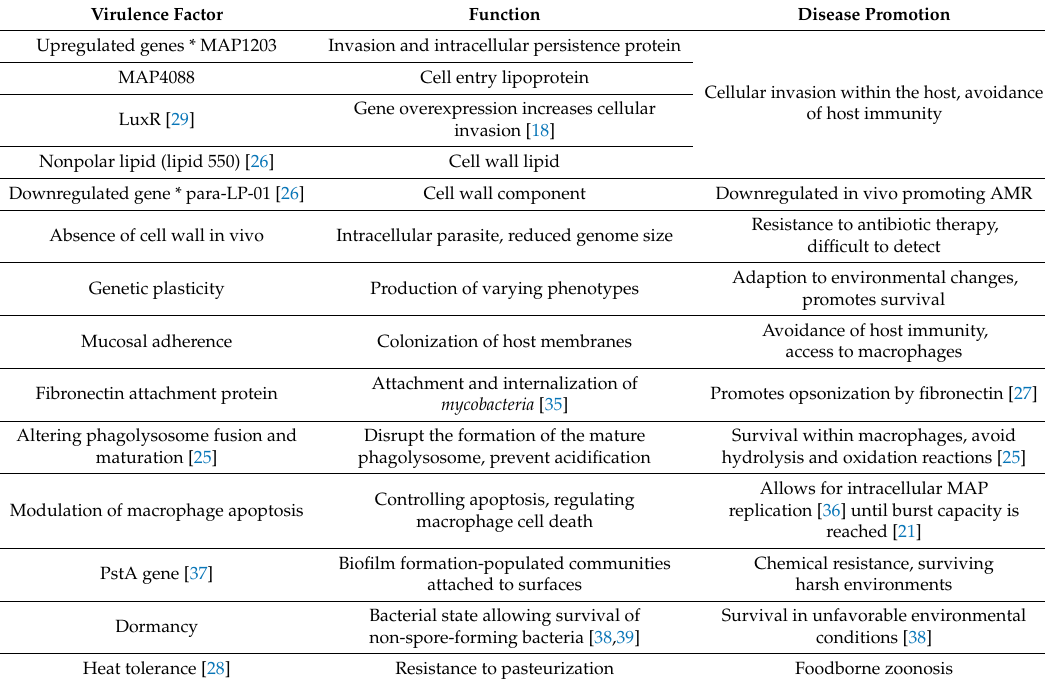
Table 1. Mycobacterial virulence factors promoting infection and